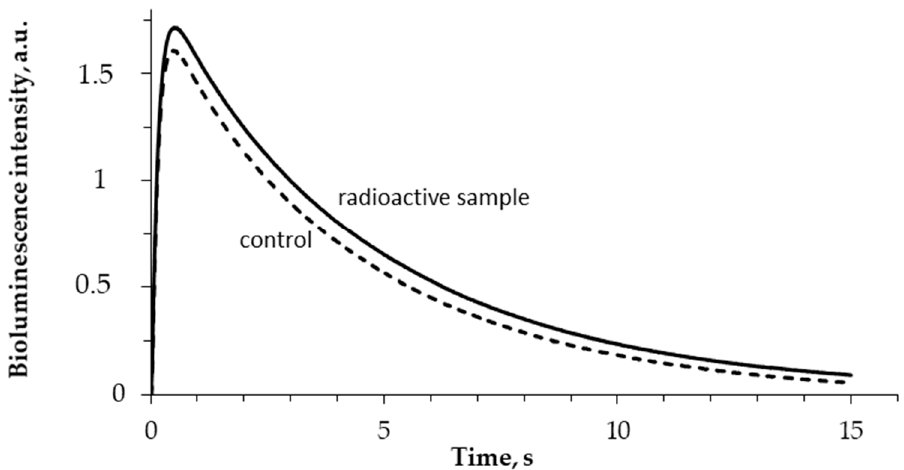
Figure 4. Bioluminescence kinetics in the reaction catalyzed by bacterial luciferase. 5 min incubation; 5 MBq/L specific radioactivity of HTO.